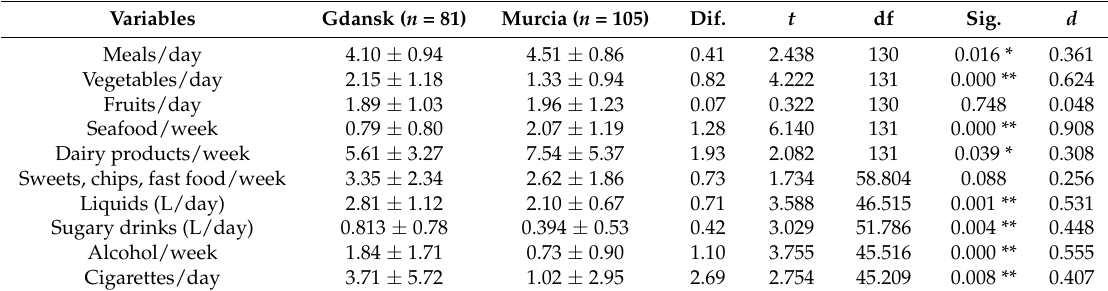
Table 4. Comparison of nutrition of males from Gdansk and